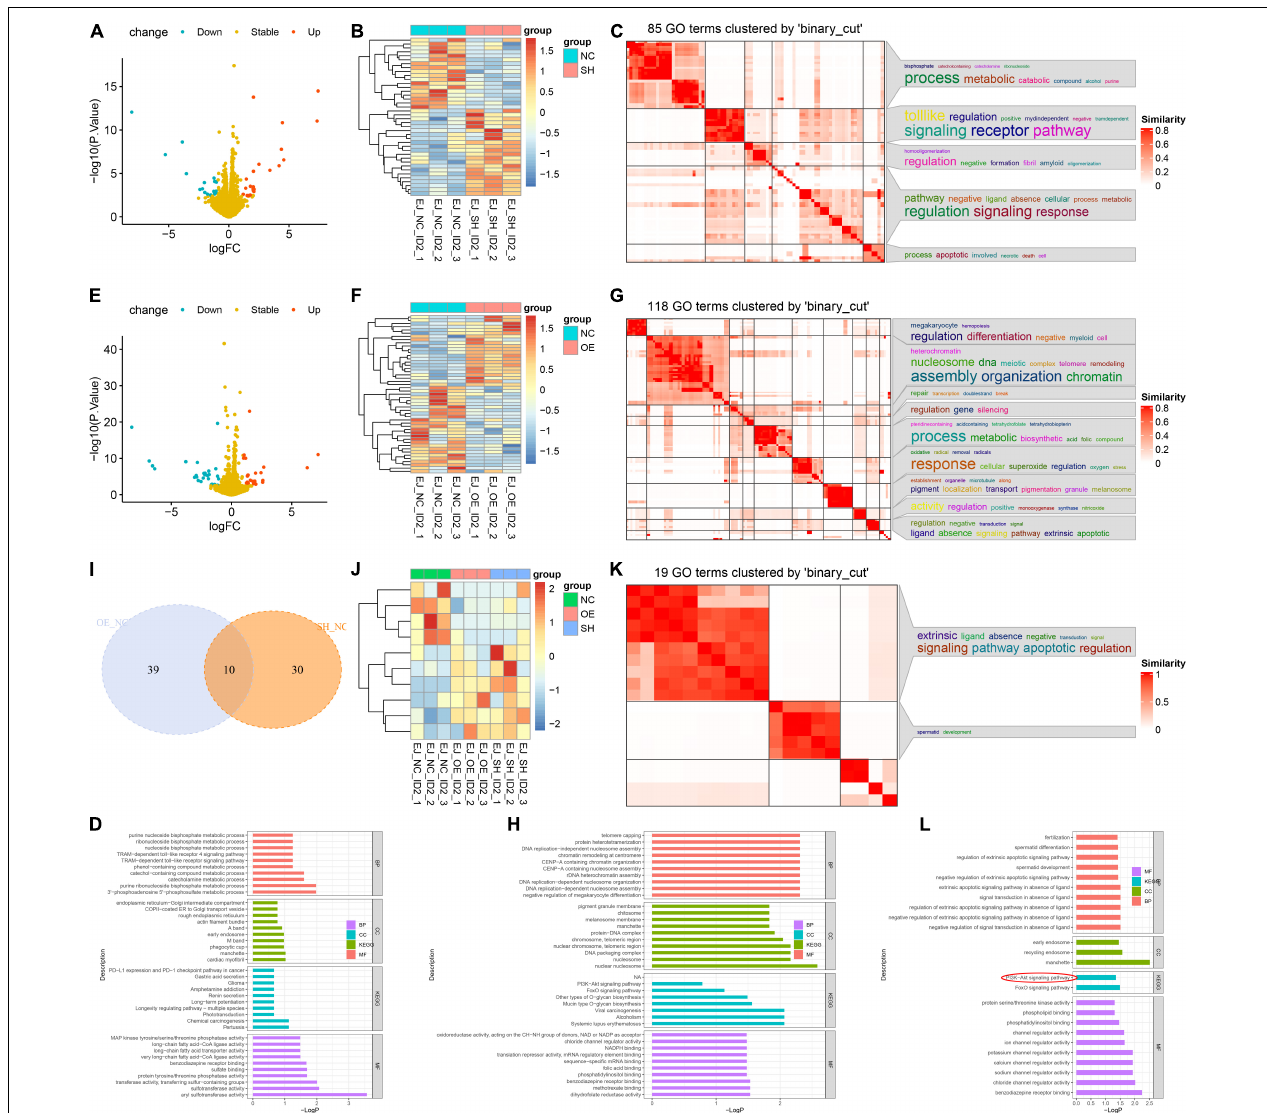
FIGURE 5 | ID2 regulated BCa progression via PI3K/AKT signaling pathway. (A,B) Volcano plot (A) and heatmap (B) of RNA-Seq analysis of NC-ID2 and sh-ID2 cells. (C,D) GO terms (C) and KEGG analysis (D) to detect differentially expressed genes. (E,F) Volcano plot (E) and heatmap (F) of RNA-Seq analysis of NC-ID2 and OE-ID2 cells. (G,H) GO terms (G) and KEGG analysis (H) to detect differentially expressed genes. (I) Venn diagrams show the number of genes with changes in NC-ID2 and sh-ID2, NC-ID2, and OE-ID2. (J) Heatmap of RNA-Seq analysis of sh-ID2, NC-ID2, and OE-ID2 cells. (K,L) GO terms (K) and KEGG analysis (L) to detect differentially expressed